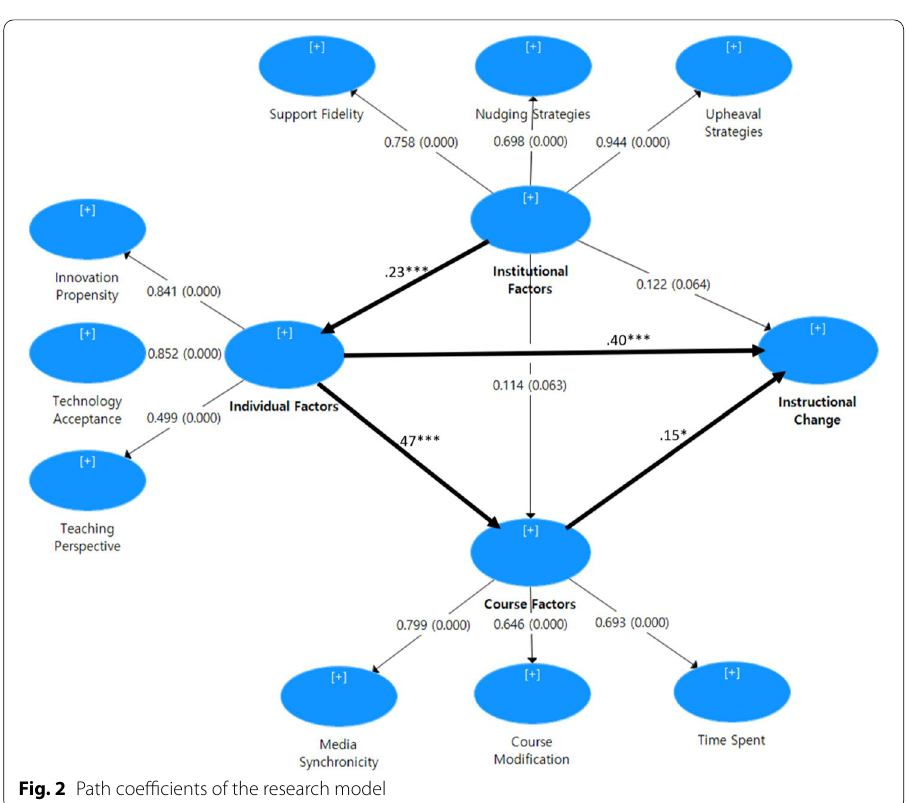
Fig. 2 Path coefficients of the research